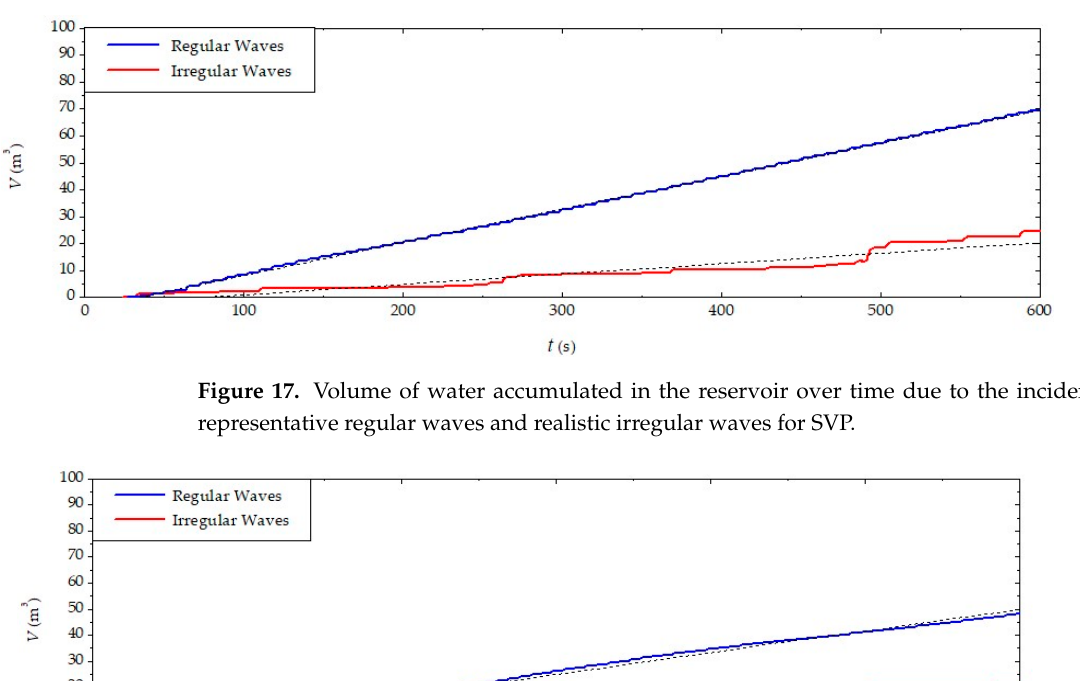
Table 3. Statistical parameters of curve fitting.